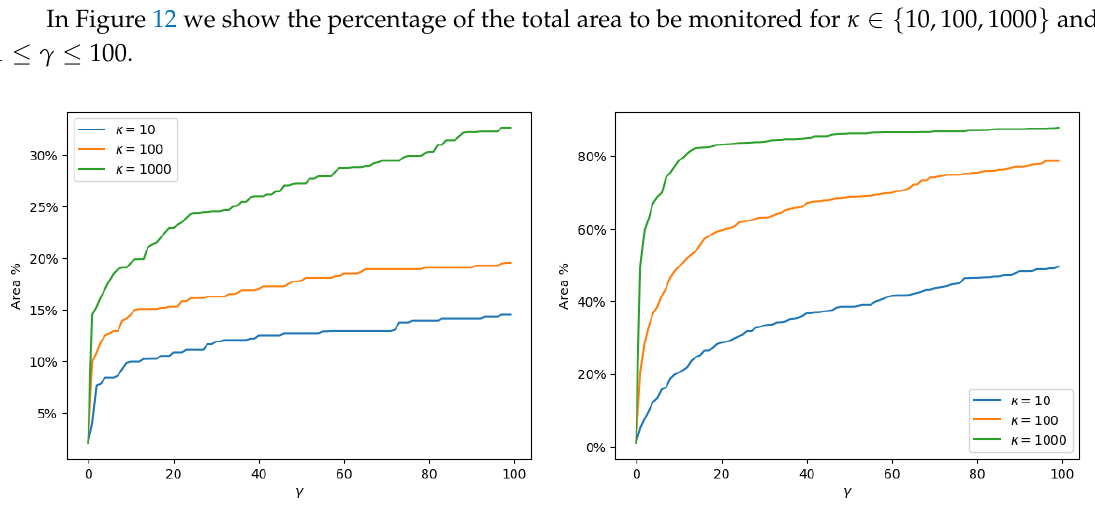
Figure 12. The figure shows the percentage of the total area to be monitored where the optimal decision would be confirming a leak. The cost function is altered by varying the parameter κ and γ in Equation (7) and Table 3. The three different lines represents varying κ , and the the x-axis shows varying γ for each scenario. Increased cost difference between the operational cost and the cost of confirming a leak, result in a higher degree of confirmation, faster. ( Left Panel ) The MAP of the predictive posterior distribution. ( Right Panel ) The expectation of the predictive posterior distribution. Using the mode instead of the expectation results in less